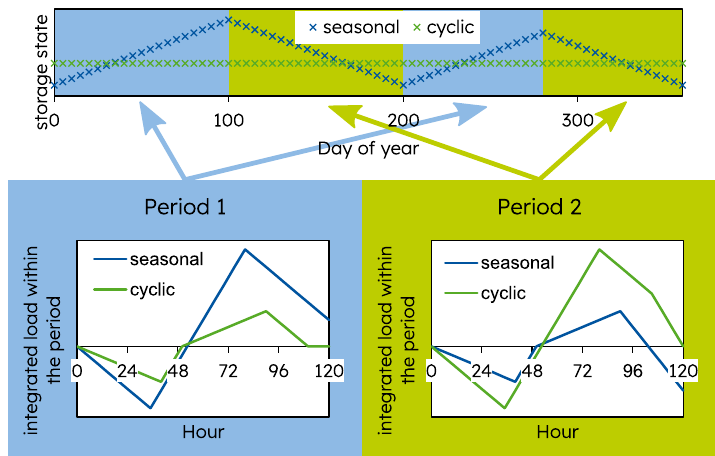
Fig. 1 Seasonal storage model of Kotzur et al. explanation